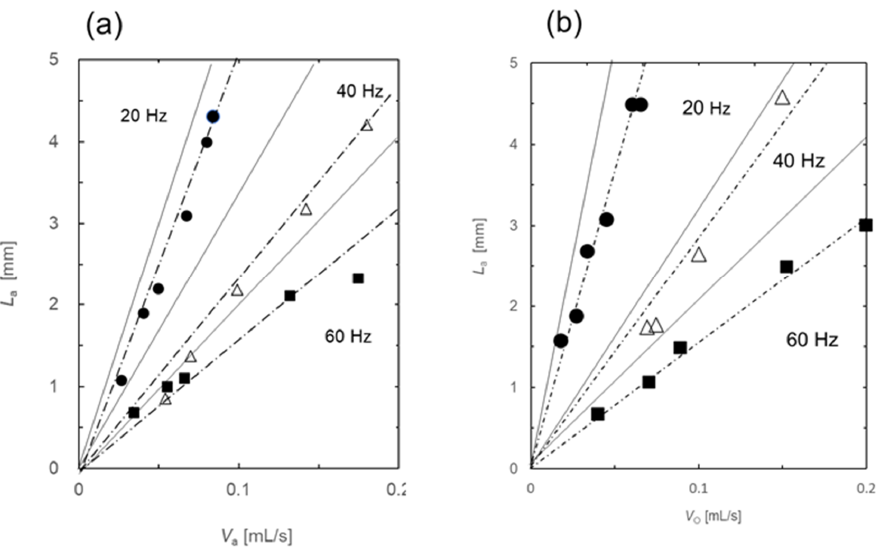
Figure 3. Effect of frequency on volumetric flow rate under various kinematic viscosities of oil phase.